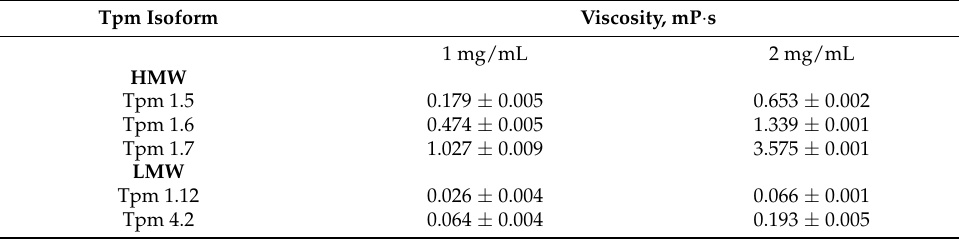
Table 1. Excess viscosities of Tpm isoforms solutions over buffer viscosity.